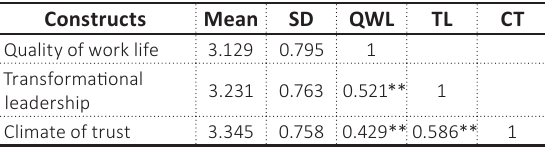
Table 1. Mean, standard deviation, and